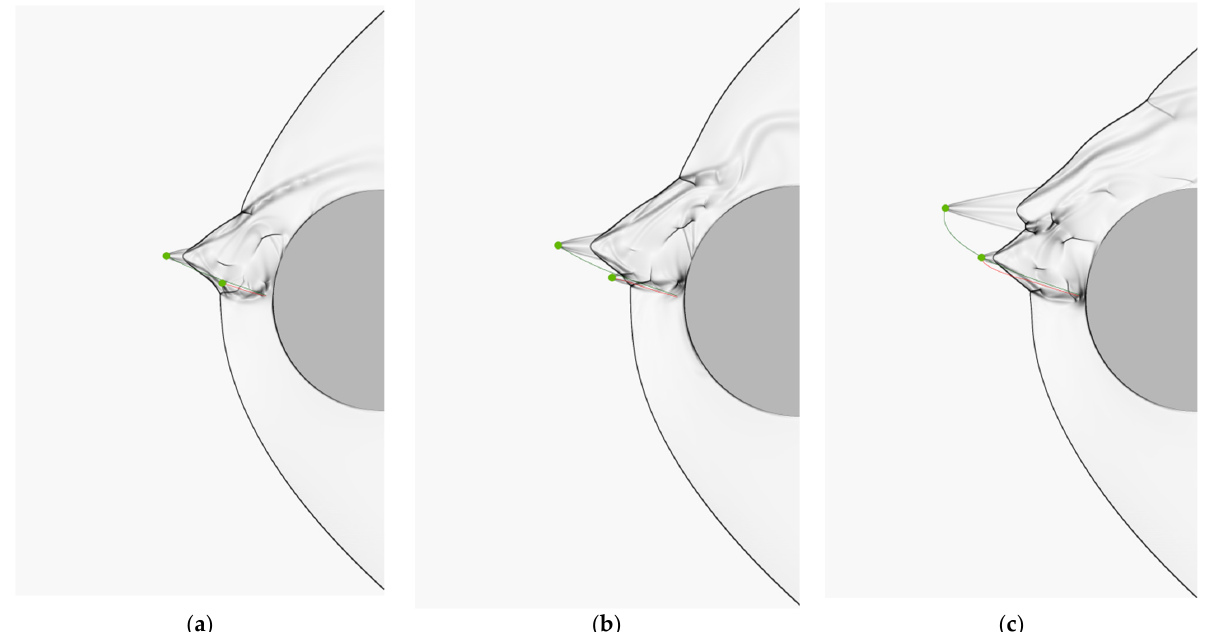
Figure 7. Schlieren images at successive times. ( a )—0.3 ms, ( b )—0.38 ms, ( c )—0.69 ms. Variant 2 with two particles.